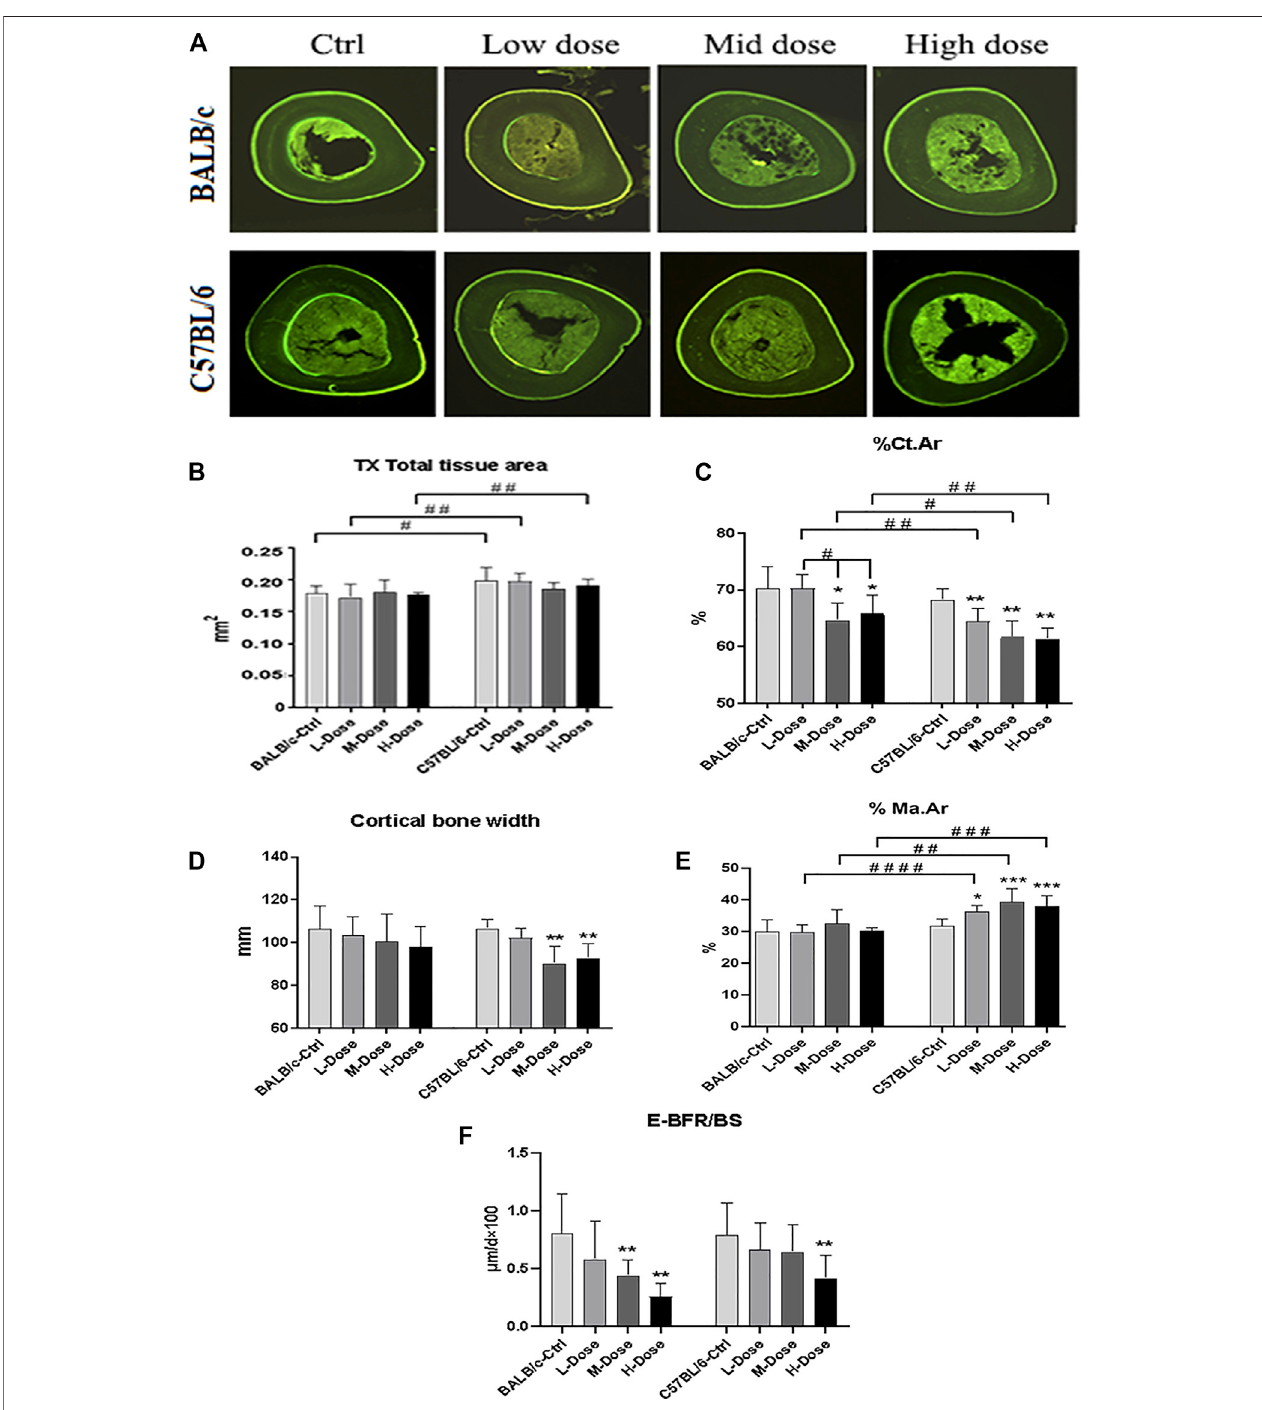
FIGURE 2 | Changes of Cortical bone ofBALB/c and C57BL/6 in dexamethasone treatment. (A) Images ofTX transverse section fl uorescence detection (injected with calcein). (B – E) Static parameters of TX. (F) Dynamic parameters of TX. * p < 0.05, ** p < 0.01, signi fi cantly different from Ctrl; # p < 0.05, ## p < 0.01, signi fi cantly different between BALB/c and C57BL/6. (%Ct.Ar, percentage cortical area; %Ma.Ar, percentage marrow area; E-BFR/BS, cortical bone endosteal formation rate).